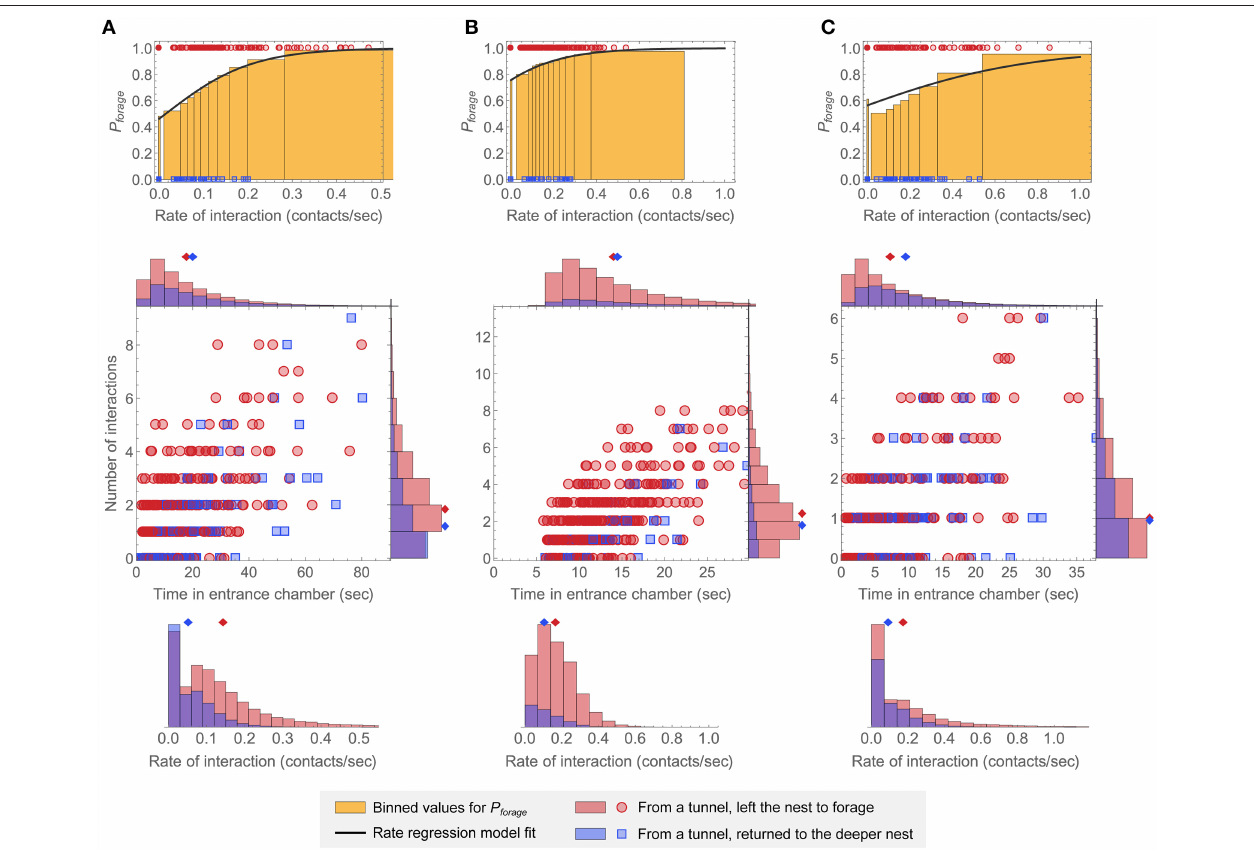
FIGURE 7 | Simulated model distributions representative of other colony observations. The parameters in (A–C) were chosen so that the simulated distributions resemble the observations of colonies 1, 3, and 4, respectively. The top row shows binned plots for P forage as a function of interaction rate in the same manner as Figure 4 . The solid lines are fits of the rate regression model to each set of simulated data, and 200 points are shown on each plot for illustration. The bottom row shows 2D plots and corresponding N , T, and r distributions for 400 simulated ants as in Figure 3 . (A) k = 0.26, γ = − 0.007 , s 0 = 0.06, and σ = 0.22, with r in = 0.083 taken from the data for the observation of colony 1 (Figure S2). (B) k = 0.15, γ = 0.044 , s 0 = 0.02, and σ = 0.30. To produce results resembling the time distributions for the observation of colony 3 ( Figure 3 ), a constant post-decision time without interactions of 5s. was added to each simulated ant. A value of r in = 0.25 was used to match the overall input rate of interaction for this observation when the added post-decision time is included. (C) k = 0.17, γ = − 0.012 , s 0 = 0.21, and σ = 0.35, with r in = 0.117 taken from the data for the observation of colony 4 (Figure